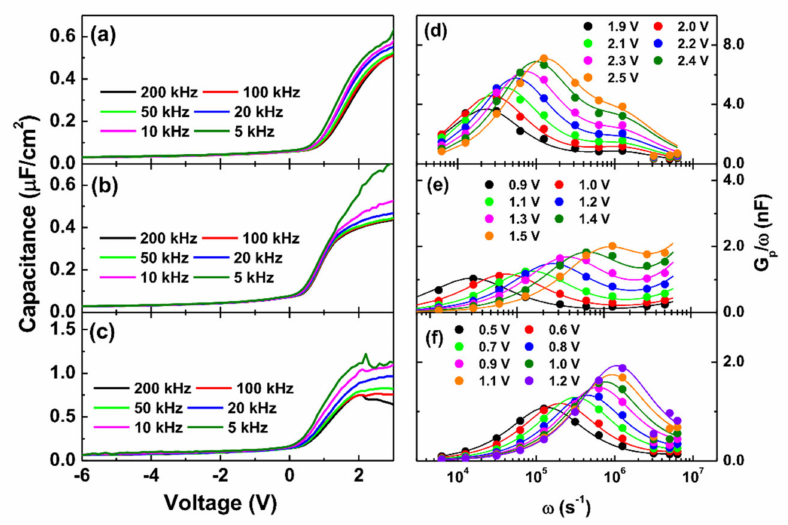
Figure 8. Capacitance–voltage ( C – V ) data at di ff erent frequencies for samples ( a ) A, ( b ) B, and ( c ) C, and frequency-dependent parallel conductance–voltage ( G p / ω – V ) curves for samples ( d ) A, ( e ) B, and ( f ) C.